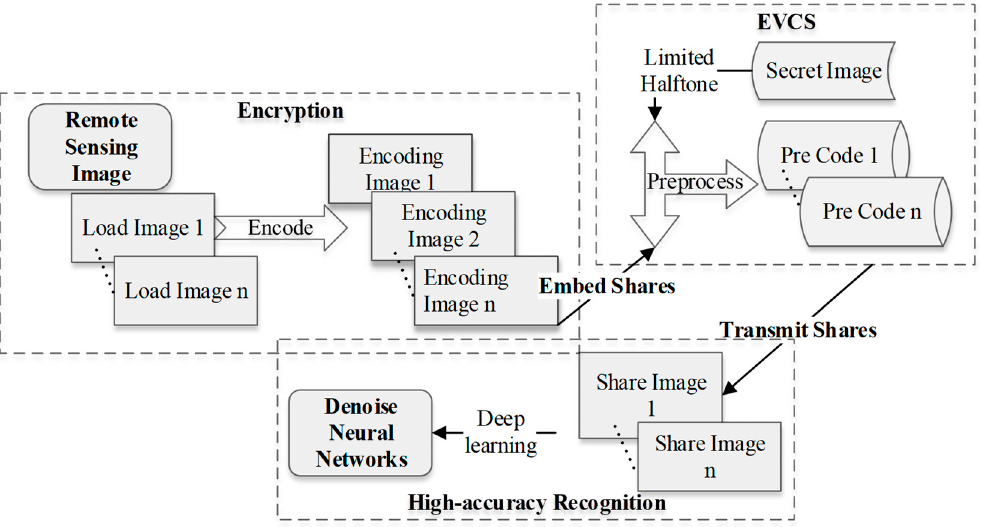
Figure 1. A lightweight privacy-preserving system for the security of remote sensing images in the IoT.